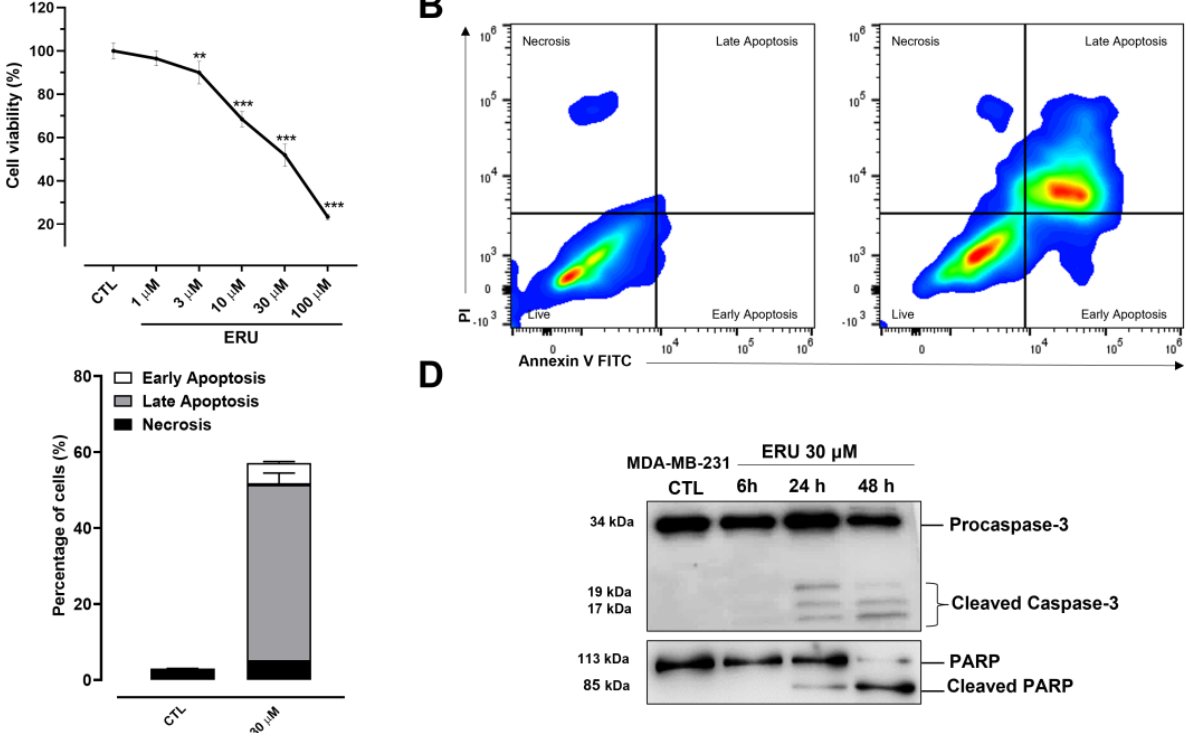
Figure 1. ERU induces apoptosis in MDA-MB-231 cells. ( A ) MTT proliferation assay was performed in MDA-MB-231 cells treated with ERU 1 − 100 µM for 48 h. ( B ) Flow cytometric analysis of apoptosis detected by Annexin V/propidium iodide (PI) staining in MDA-MB-231 cells treated with ERU (30 µM) for 48 h. ( C ) Quantitative analysis of apoptosis showing that at 48 h, about 60% of MDA-MB-231 cells treated with ERU exhibit markers of apoptosis. ( D ) Western blot analysis of Caspase-3 and PARP on MDA-MB-231 whole-cell lysates after treatment with ERU (30 µM) for 6, 24, and 48 h. The data shown are representative of three independent experiments ( n = 3) with similar results. ** p < 0.01; *** p < 0.001 vs. CTL.